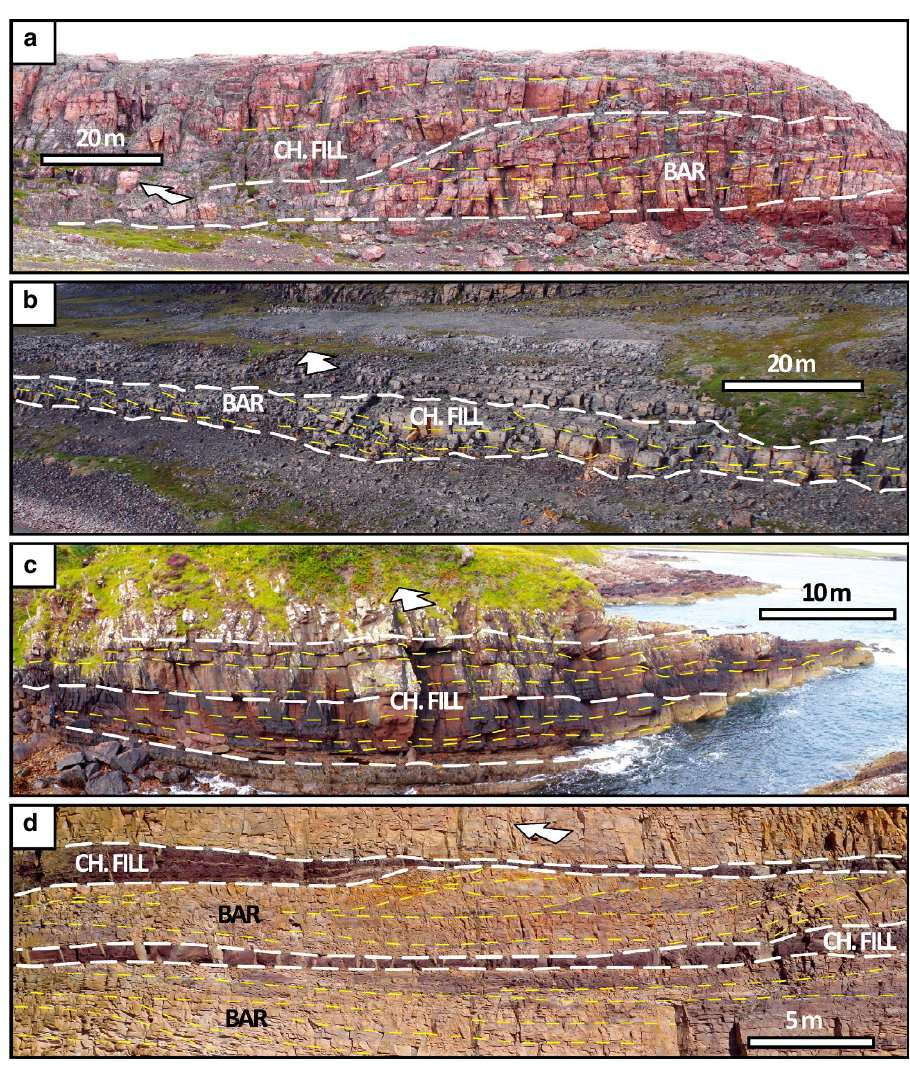
Figure 4 | Field aspects of Proterozoic channel forms. ( a , b ) Active-channel fills sided by bank-attached bars in the Burnside River ( a ) and Ellice ( b ) formations. The geometry of the channel fills (when entirely observable from satellite) is considered as an approximation of the alluvial section during the last major flood. ( c ) Stoer group: aggradational, active-channel fill containing low-relief in-channel bars. Despite prominent bed aggradation, the tallest bar slip-face ( B 4m) provides a first-order approximation of maximum channel depth. ( d ) Nelson Head formation: red-coloured abandoned-channel fills attached to mid-channel and bank-attached bars (tan-coloured). The upper red unit is part of a fully preserved channel form; the lower red unit is scoured by the overlying deposits and is not considered in the data